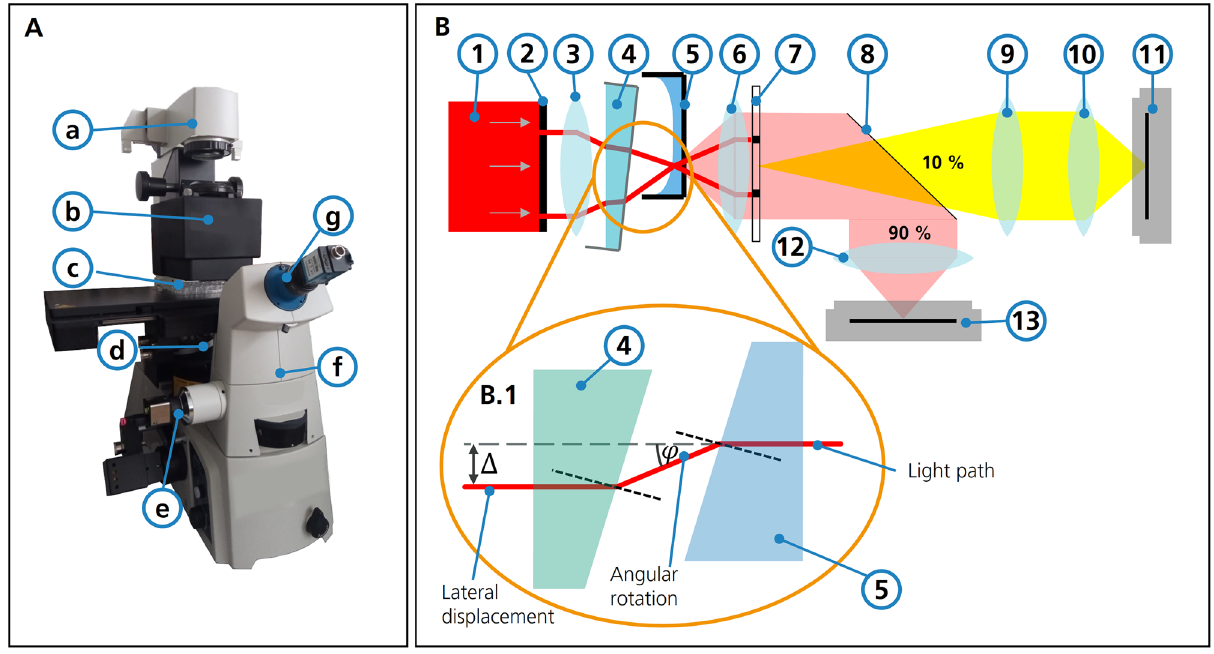
Figure 2. Setup of modified microscope and simplified light path. ( A ) Setup of the elements within an inverse microscope. (a) Light source (b) Optical components adapter (c) MTP (d) Objective lens (e) Main camera (f) Beam splitter (g) Bertrand lens and secondary camera ( B ) Modified light path compared to the one presented in Fig. 1. The fixed condenser annulus (2) has been replaced by a transmissive LCD. A tunable prism (4) is introduced. The movable mirror (8) is replaced by a 90/10 beam splitter. ( B.1 ) Working principle of the compensation considering refraction on liquid surfaces (same refractive index in prism and cell medium